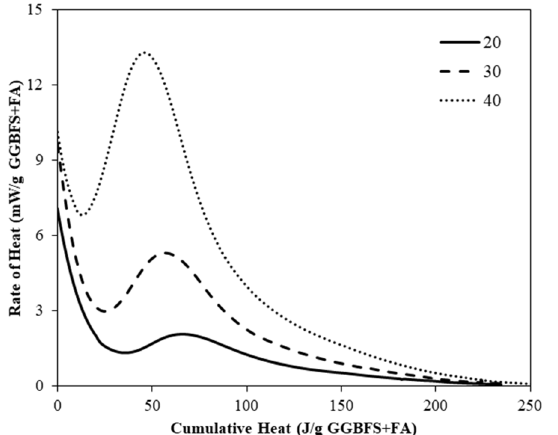
Figure 2. Effect of temperature (20, 30 and 40 °C) on the rate of heat released with respect to the cumulative heat released. Fig. 3 (top) shows the evolution of apparent activation